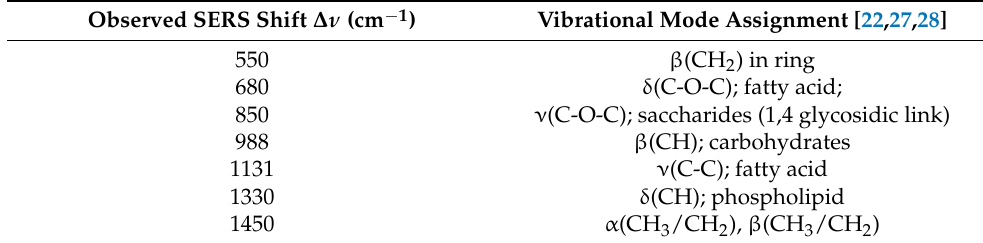
Table 1. SERS peak assignment for Neisseria meningitidis LPS structures.